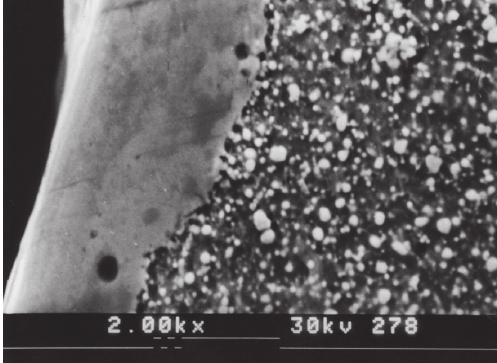
Figure 8: SEM micrograph of modified punch surface.